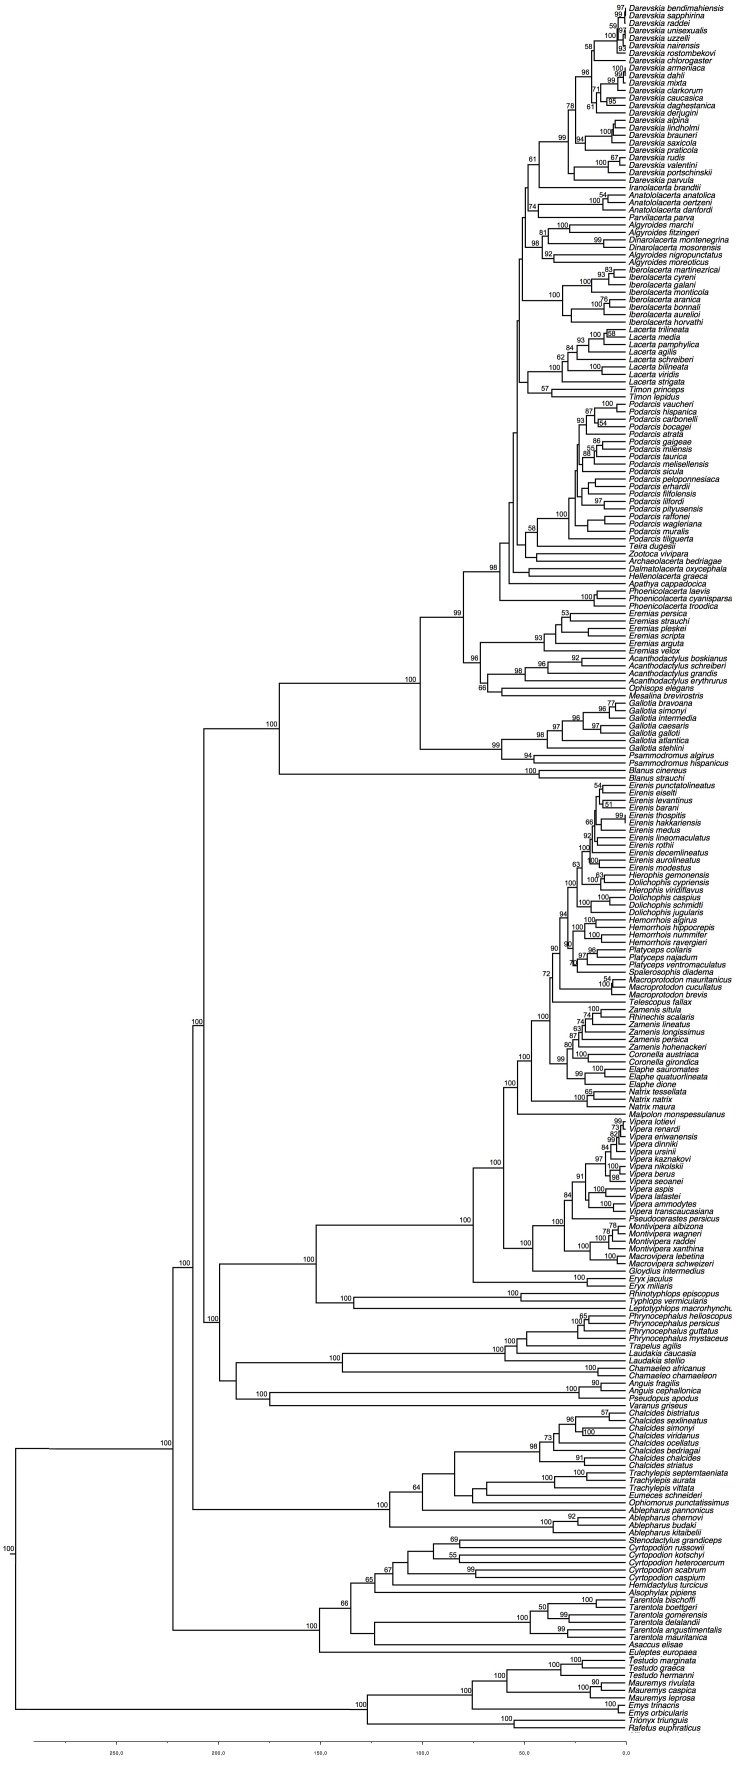
Phylogenetic tree obtained by maximum likelihood inference with
RaxML (outgroups have been removed). Numbers above branches
indicate bootstrap values.